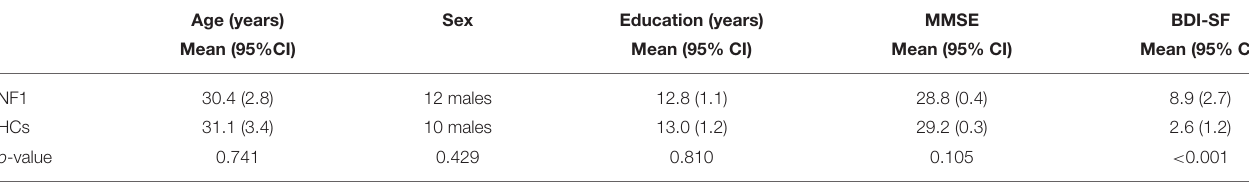
TABLE 1 | Demographic characteristics of